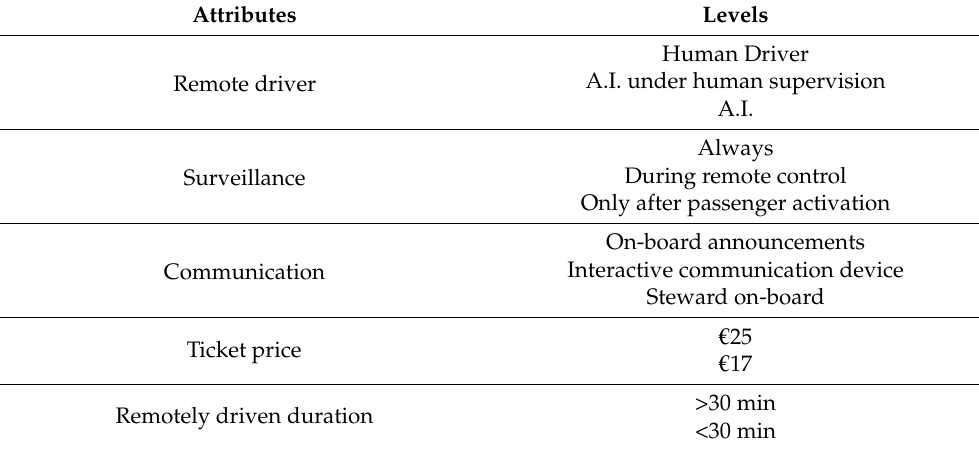
Table 1. CBC attributes and attribute